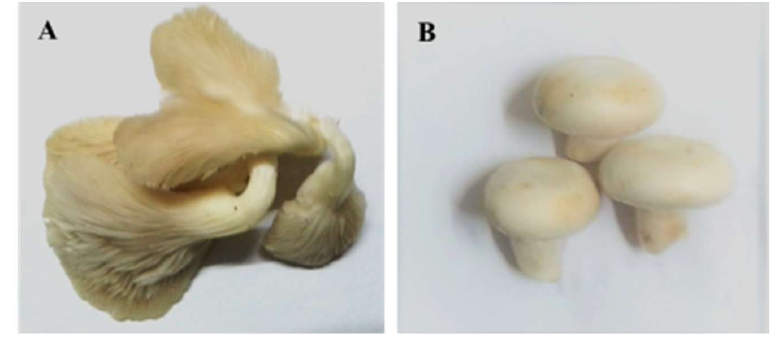
Figure 1. P. ostreatus ( A ); and A. bisporus ( B ).